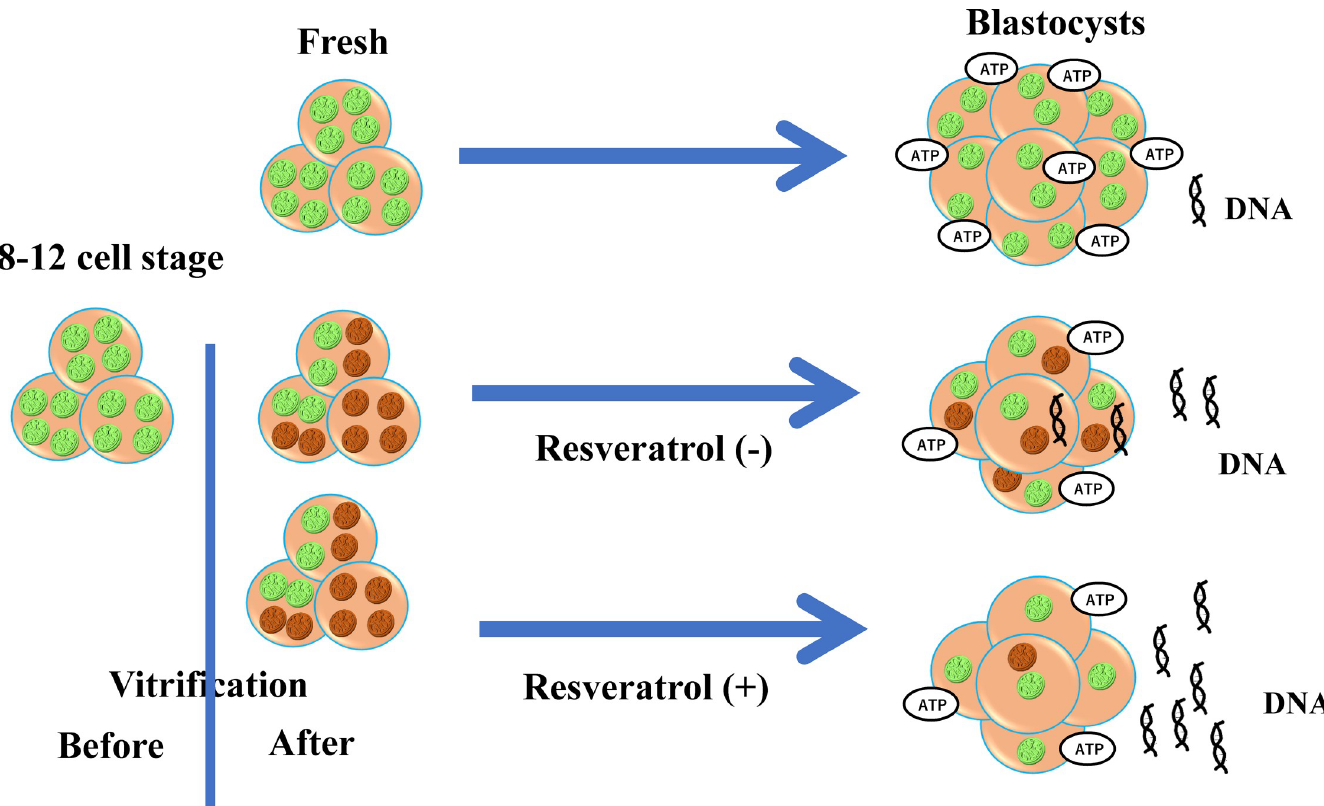
Fig 8. Schematic diagram of the effect of resveratrol on mitochondria in blastocysts derived from post-warming embryos. Before vitrification, the blastomeres of embryos (left side) contained healthy mitochondria (green dots), but vitrification induced mitochondrial damage (brown dots). The blastocysts derived from the vitrified-warmed embryos had low numbers of blastomeres; however, these blastocysts still contained similar numbers of mitochondria per blastomere as compared to the blastocysts derived from fresh embryos (non-vitrified, upper right). Supplementation of the culture medium with resveratrol improved the process of embryonic development up to the blastocyst stage, and the resultant blastocysts had similar numbers of blastomeres but lower numbers of mitochondria per blastomere (lower right). This reduced mitochondrial number corresponded to an increase in cell-free mitochondrial DNA in the spent culture medium and a decrease in dsDNA in the